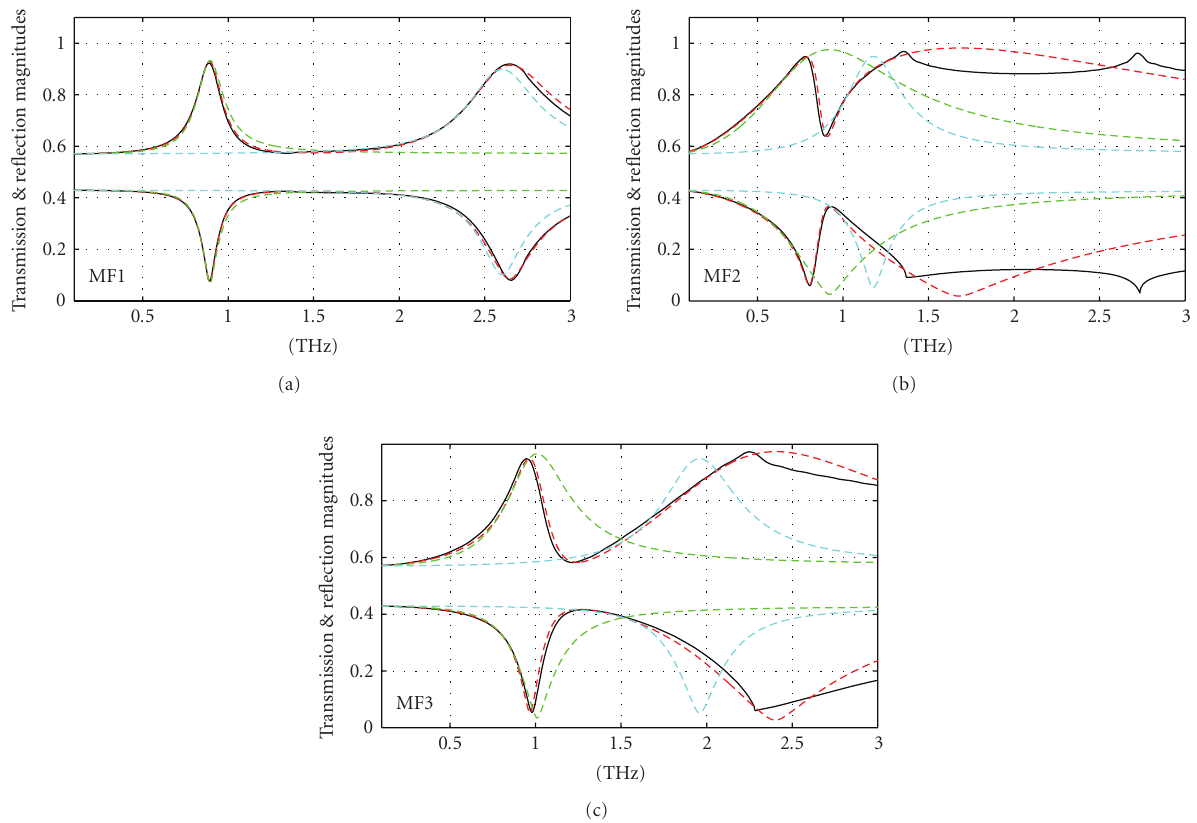
Figure 4: Transmission and reflection coe ffi cients based on simulation and the TL-RLC circuit model for metafilm samples MF1, MF2, and MF3. Simulation results are shown in black. Red-dashed curves show the combined reflection and transmission coe ffi cients based on the TL-RLC model. Green and blue dashed curves show the individual low and high frequency resonances, respectively, calculated by setting either R 1 or R 2 to a very large